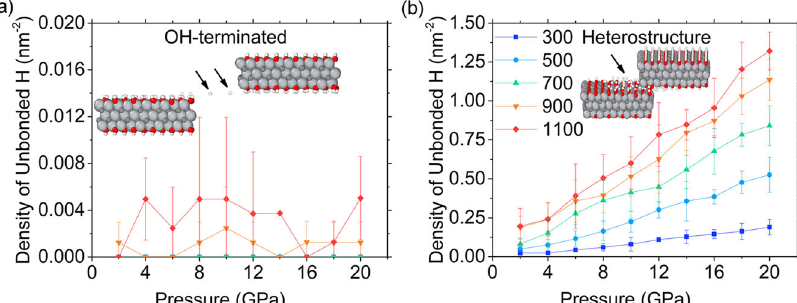
Fig. 6 Unbonded hydrogen atom densities. Density of unbonded H atoms for the a OH-terminated and b heterostructure MXenes as a function of pressure at 300, 500, 700, 900, and 1100 K averaged over the duration of sliding. The inset snapshots of both MXenes are from a simulation performed at 1100 K and 2 GPa. The error bars re fl ect the standard error of three sliding